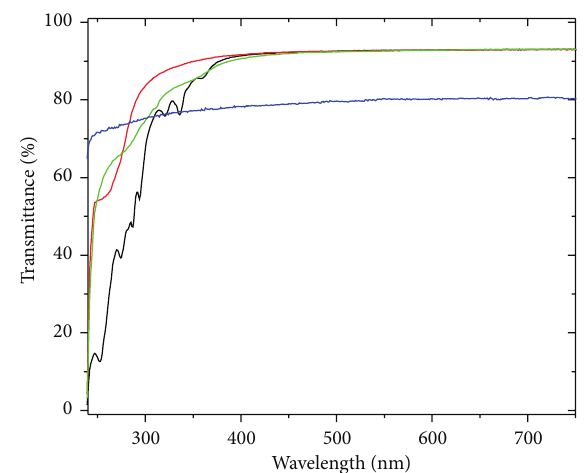
Figure 2: Transmittance spectra of the investigated ILs: BMI ⋅ NTf 2 (black), HMI ⋅ NTf 2 (red), OMI ⋅ NTf 2 (green), and DMI ⋅ NTf 2